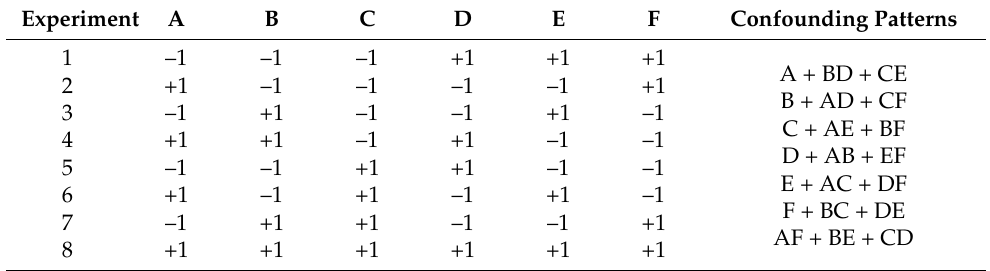
Table 3. Matrix of experiments.